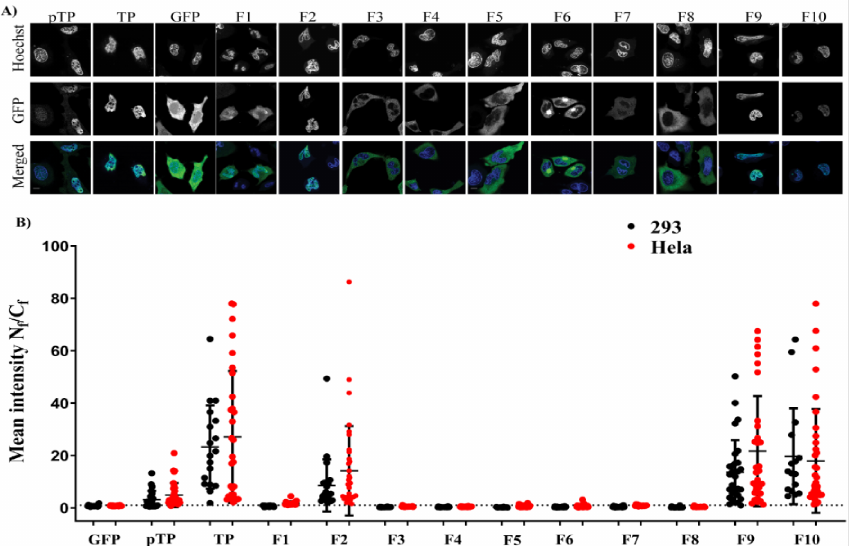
Figure 2. Expression and localisation of pTP, TP, pMax, F1–F10 fragments. Plasmids containing the fragments fused to the C–terminal of GFP or GFP plasmid alone (designated pMax) were transfected into HeLa cells ( A ) Fragments: 1–10, GFP, TP and pTP. ( B ) The mean fluorescence intensity ratio between the nucleus and cytoplasm of the fused fragments. Total fluorescence in the nuclear region (N f ) and the cytoplasmic region (C f ) was measured and calculated as described in the Methods section and plotted as N f /C f values. Analysis of the graph was performed using one-way ANOVA followed by Tukey’s multiple comparisons analysis (details of the comparisons are described in Table S4 and Table S5). The dotted line represents an N f /C f value of 1. Each dot represents a single cell. Data were pooled from two separate transfections, and all plasmids were sequenced before transfections. The mean values and the exact number of replicates for each condition are described in Table S3. Each condition was represented by at least 15 cells. All data are represented as mean ± standard deviation. Scale bar = 10 µ m.